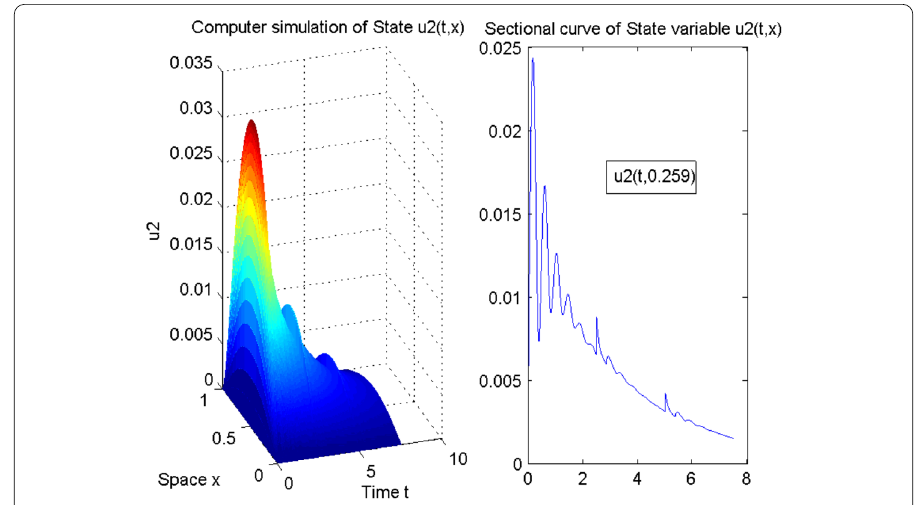
Figure 2 Computer simulations of the state u 2 ( t , x